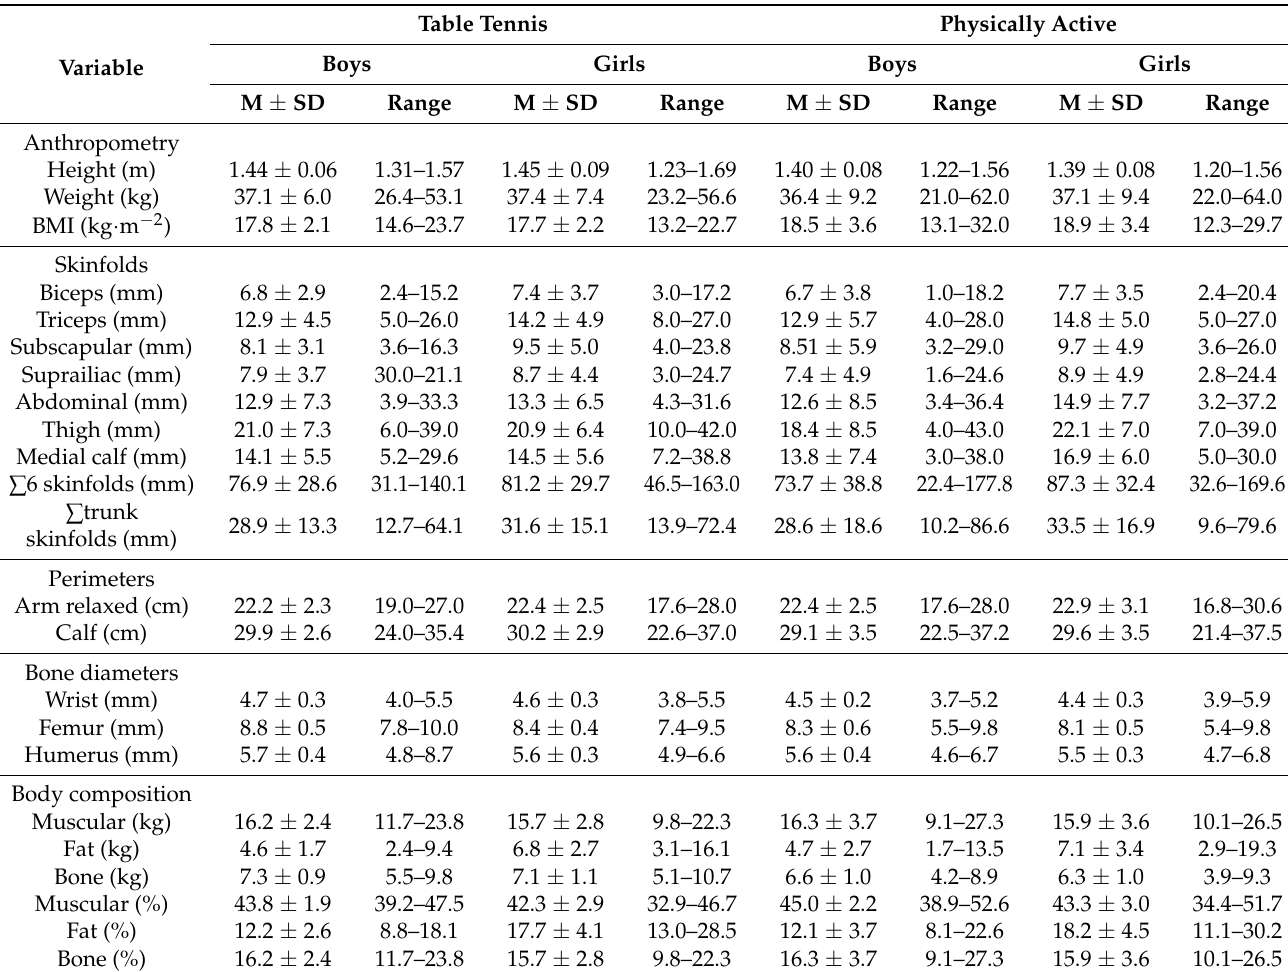
Table 1. Anthropometric, body composition, and fitness characteristics of the